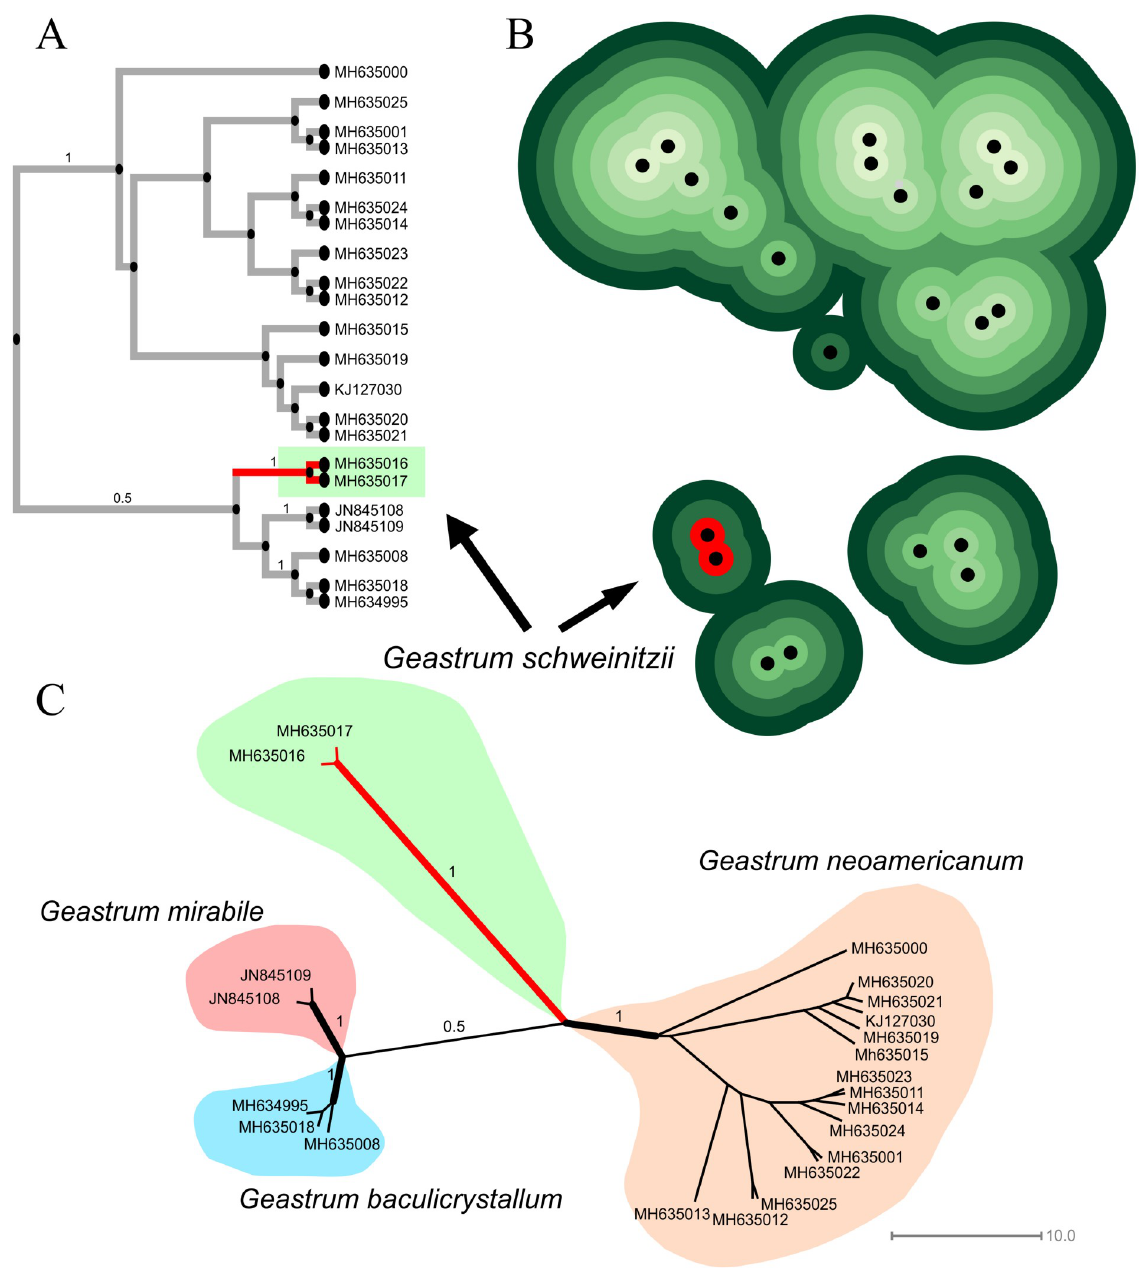
Fig 3. Analysis involving species of Geastrum schweinitzii complex. (A) Bayesian analysis conducted in Beast 2 software along 50 million generations. (B) Topo-phylogenetic and (C) phylogenetic network representations.